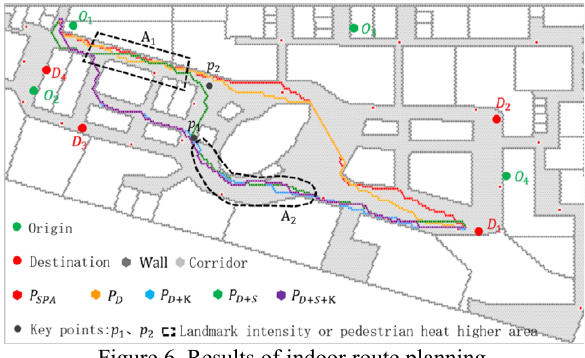
Figure 6. Results of indoor route